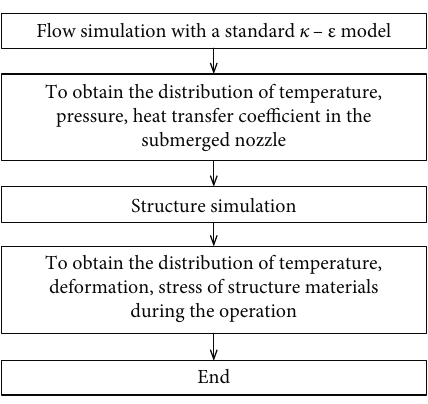
Figure 3: Flow diagram of